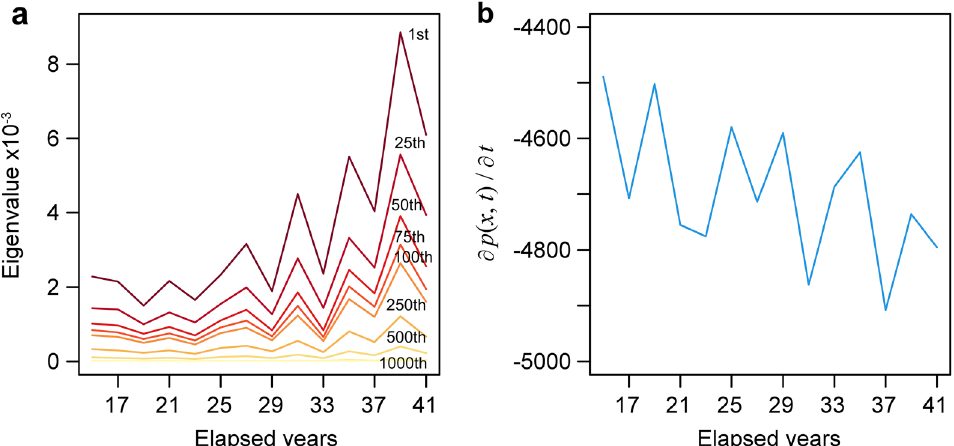
Fig. 3 a Trajectory of the representative eigenvalues with elapsed years. b Differential of the probability density of the eigenvalues with respect to elapsed years. The number in ( a ) indicate the order of the